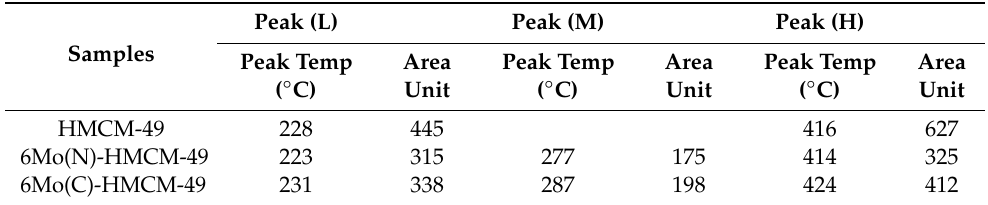
Table 3. Peak temperature of NH 3 -TPD spectra and the relative amounts of acid sites in HMCM-49 and Mo-HMCM-49.